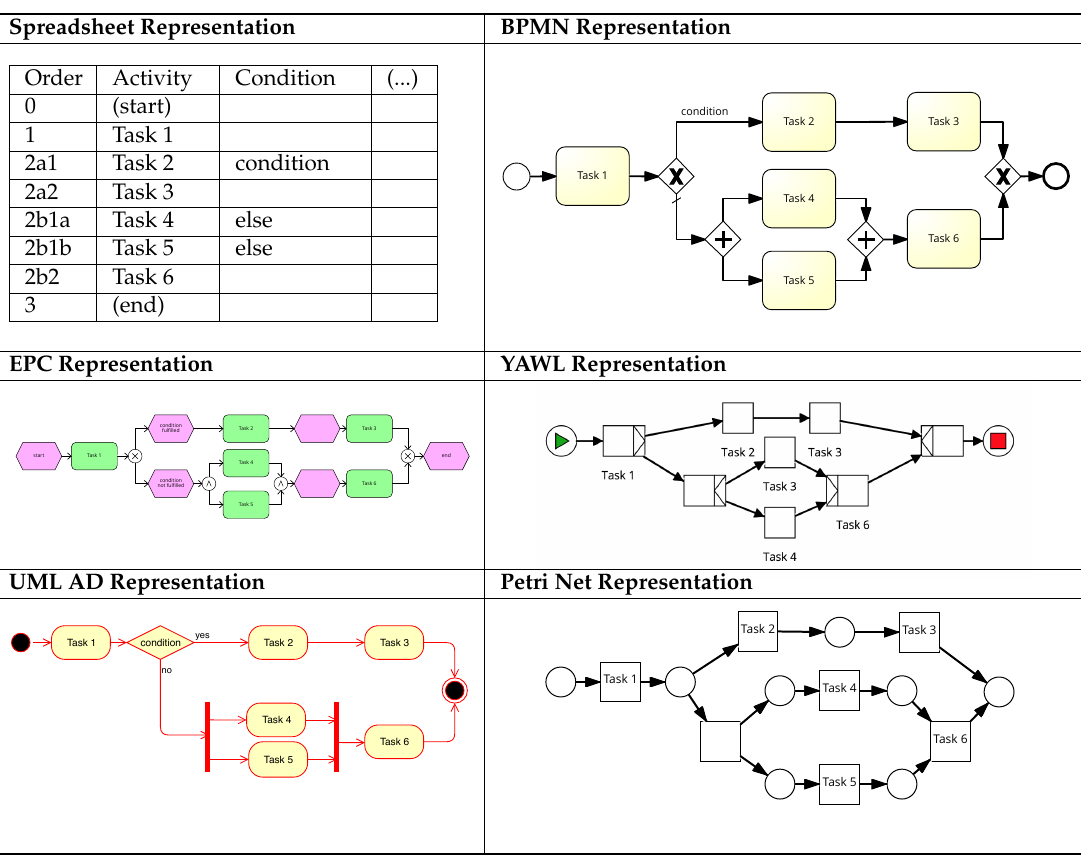
Table 12. Multiple (nested) gateways example.